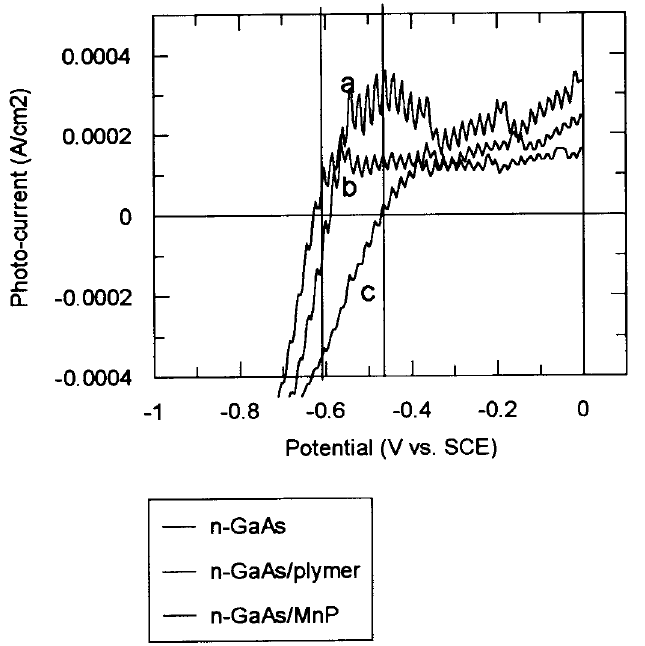
FIGURE 2 Effect of attachment of MnP = polymer on the photocurrent-potential characteristics for (a) unmodified n-GaAs, (b) polymer-modified n-GaAs and (c) Mn = polymer-modified n-GaAs electrodes. All measurements were conducted under illumination using a Xe lamp (illumination intensity at the electrode surface 0.1013Wcm (cid:2) 2 ) in = Fe(CN) 4 (cid:2) at 25 (cid:3) water = LiClO 4 = Fe(CN) 3 (cid:2) 6 6